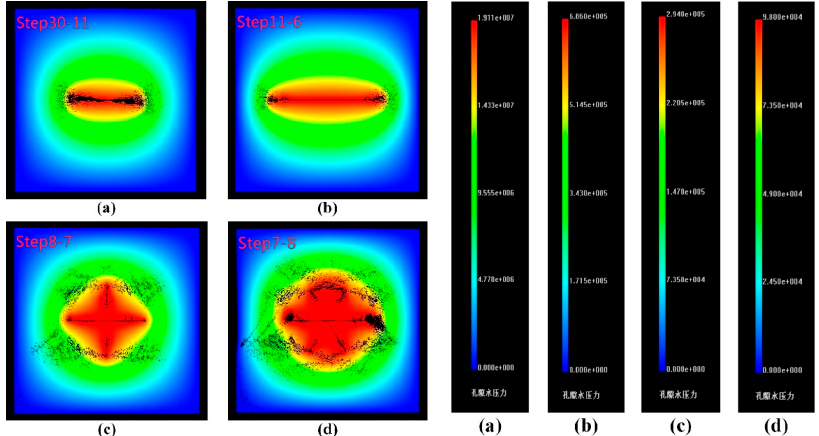
Figure 5. Models of the seepage pore-water pressure fields of four kinds of tree hydraulic fracturing, left side are the models and right side are the legends; ( a – d ) they are zero-branched, two-branched, four-branched and six-branched.